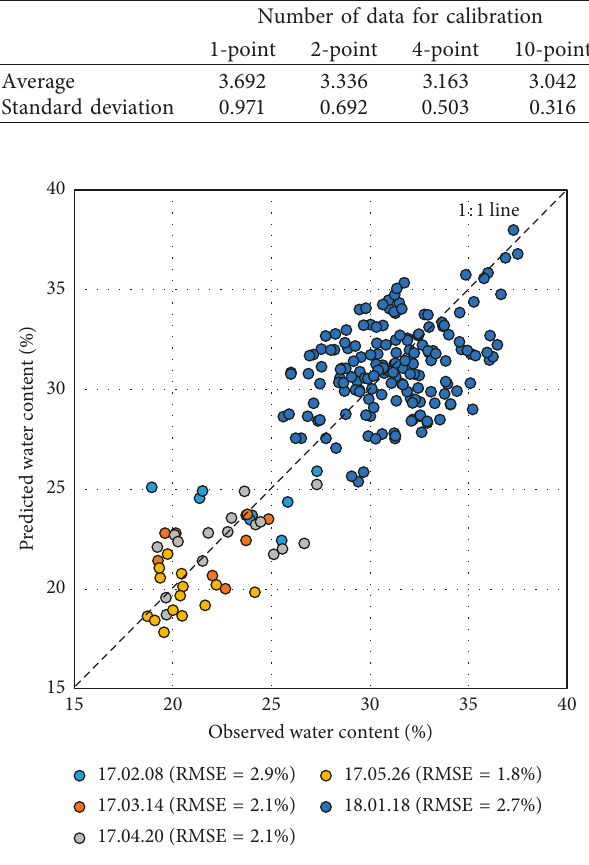
Figure 10: Comparison of observed/predicted water contents using the water content estimation